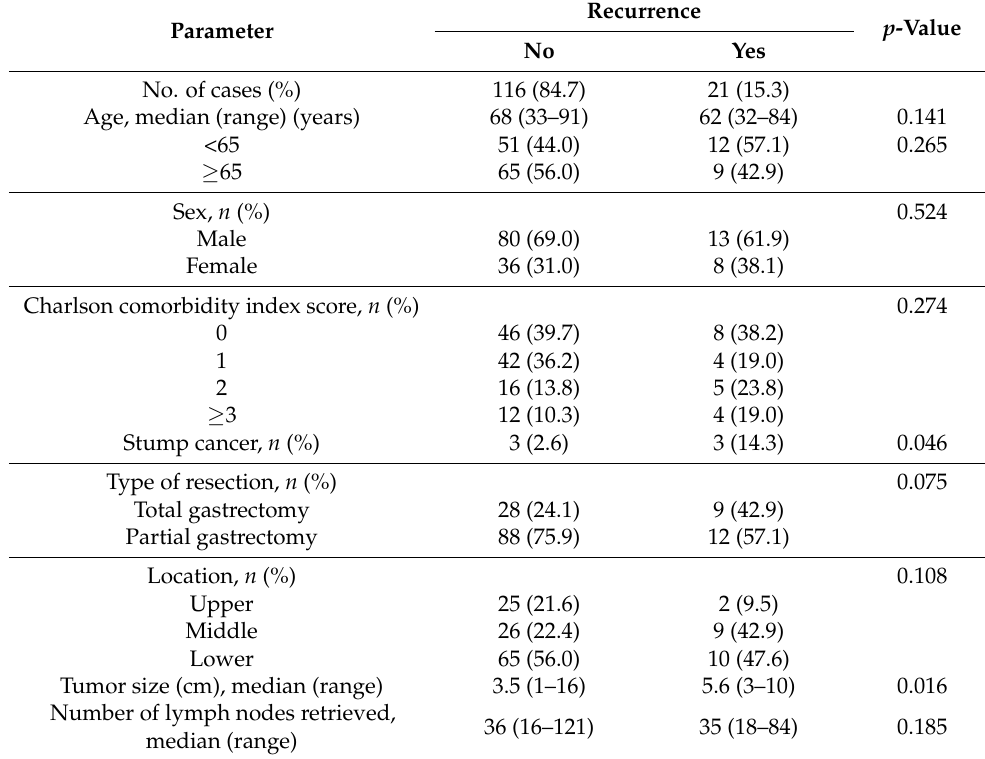
Table 2. Clinicopathological parameters of pathological T3N0M0 patients in terms of